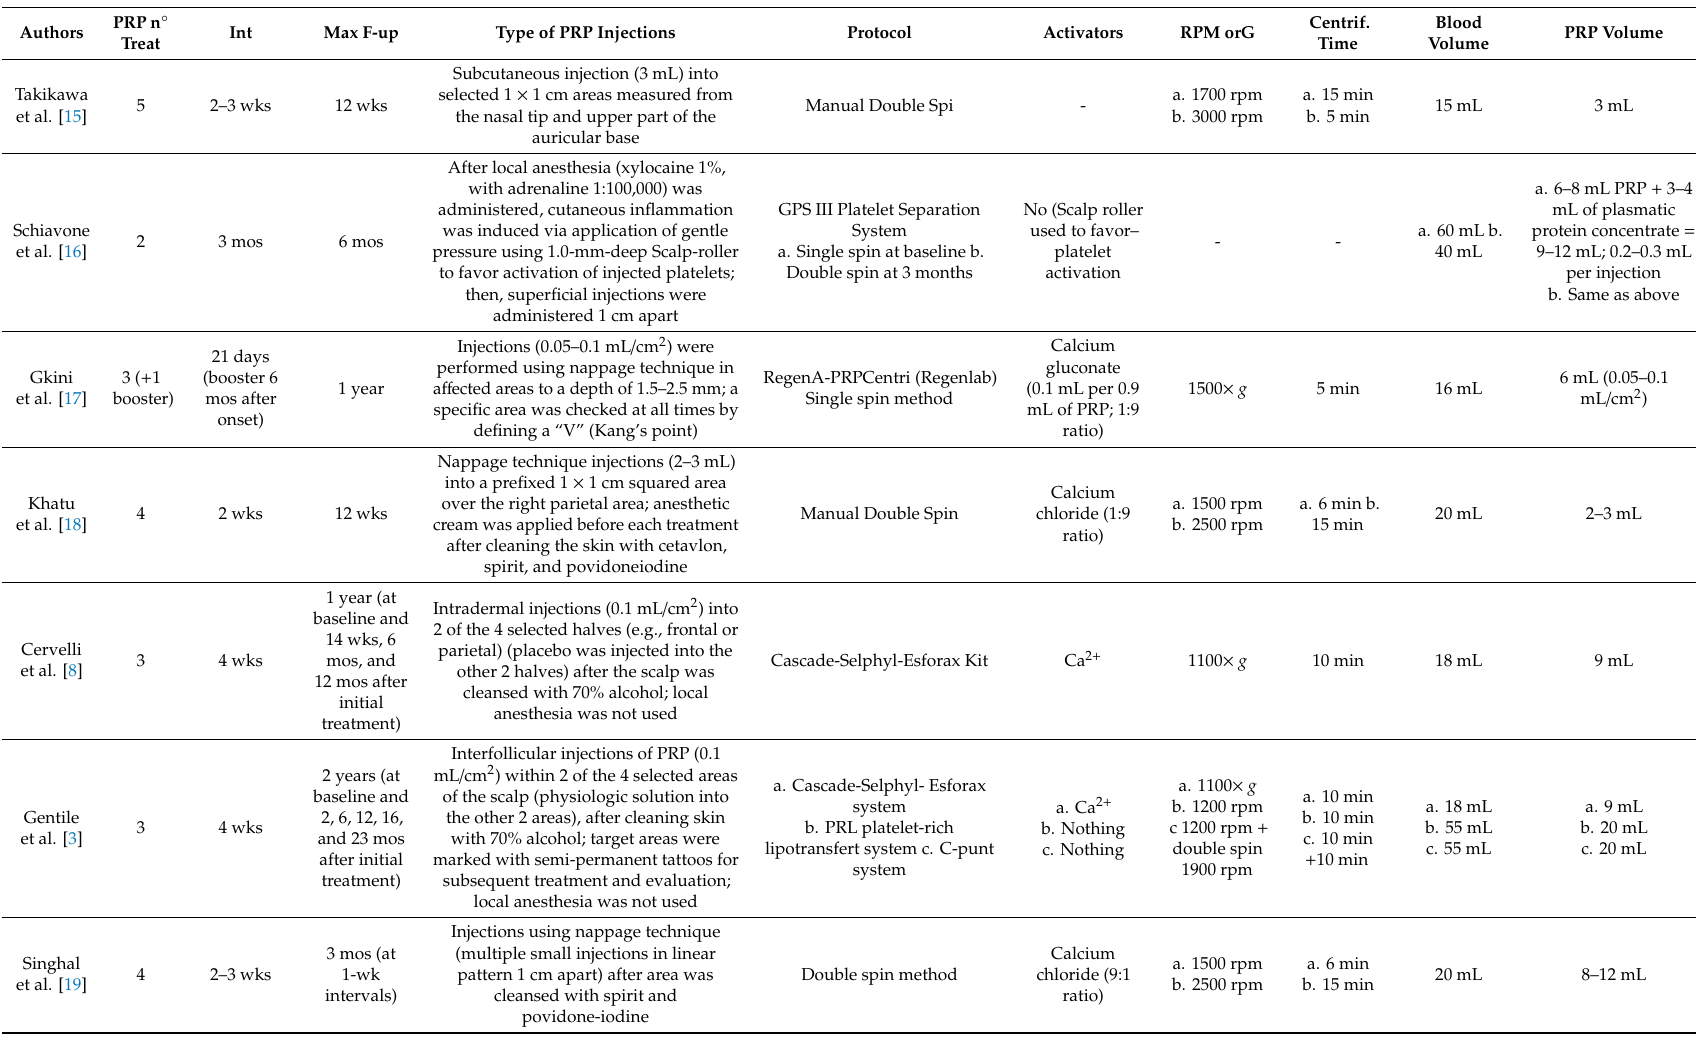
Table 2. Treatment protocols for the included trials. Abbreviations: n ◦ treat, number of treatments; Int, interval; Centrif. Time, centrifugation